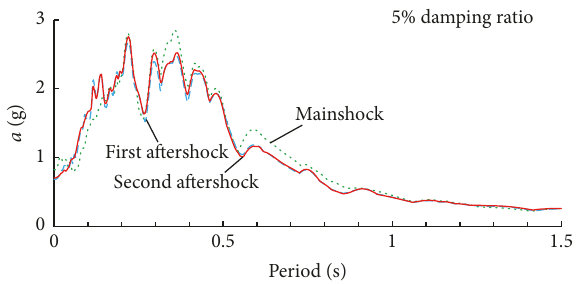
Figure 10: Effect of soil density on the spectrum acceleration of 𝑎 𝑆 .